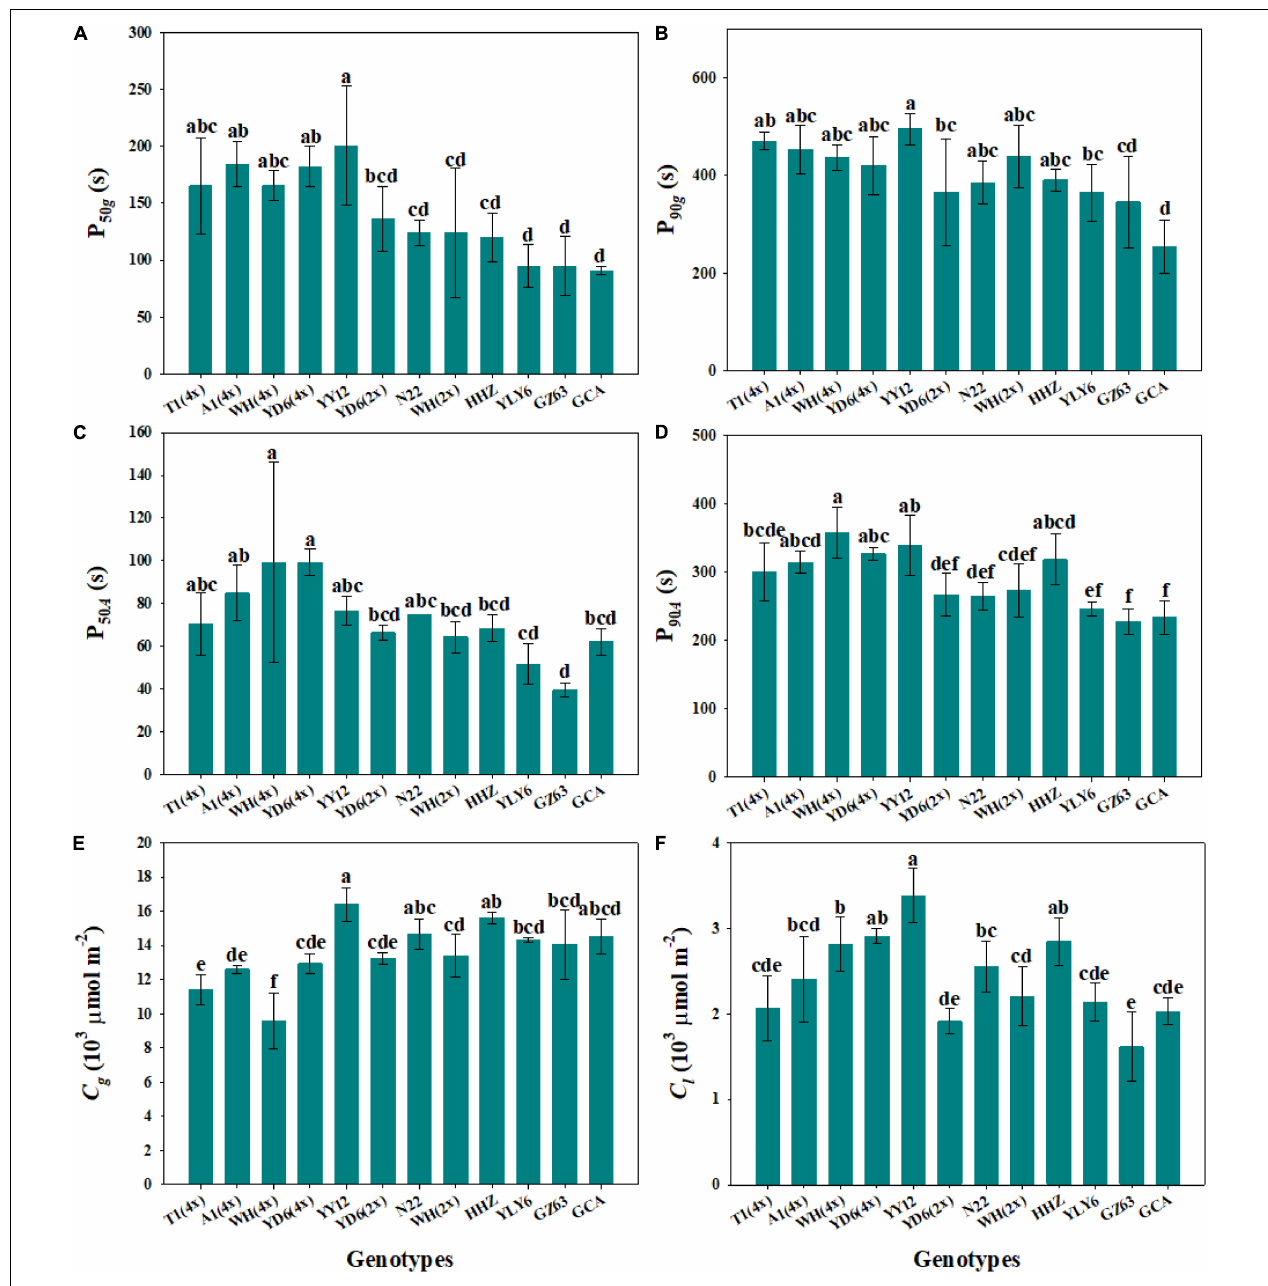
FIGURE 2 | Response rate of gas exchange parameters under a stepwise increase in light intensity across 12 rice genotypes. (A,B) Time taken for g s to reach 50% (P 50 g ) and 90% (P 90 g ) of the difference between the initial and final values. (C,D) Time taken for A to reach 50% (P 50 A ) and 90% (P 90 A ) of the difference between the initial and final values. (E,F) Integrated amount of carbon gain ( C g ) and carbon loss ( C l ) during 600 s of photosynthetic induction. Each bar represents the mean ( ± SD) of three replications. Different letters indicate statistically significant differences ( P < 0.05) among twelve rice